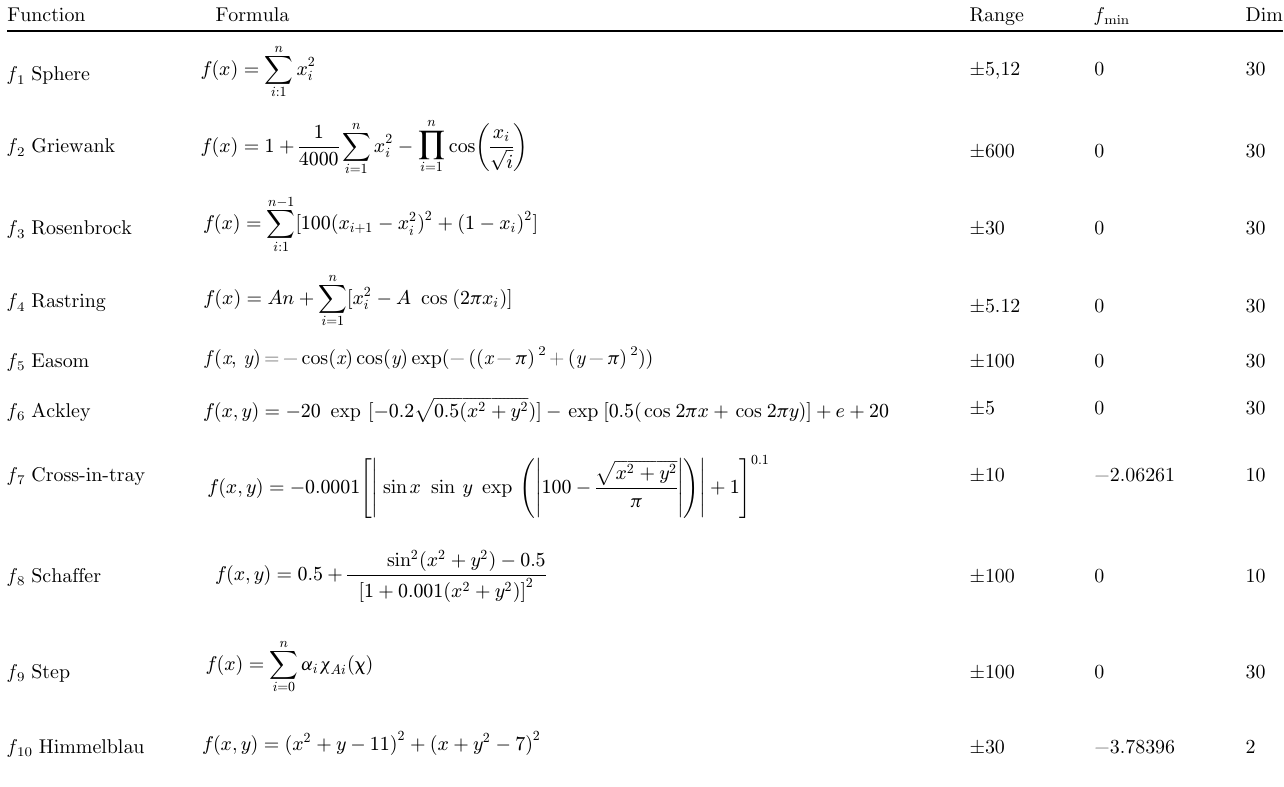
Table 2. Description of the used functions in our experiments. Function Formula